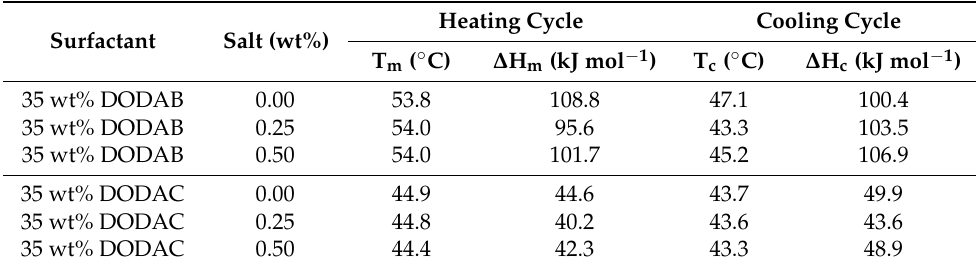
Table 4. Normalised differential scanning calorimetry parameters of 35 wt% DODAB and 35 wt% DODAC in the presence of 0.25 wt% and 0.50 wt% NaBr and NaCl, respectively.